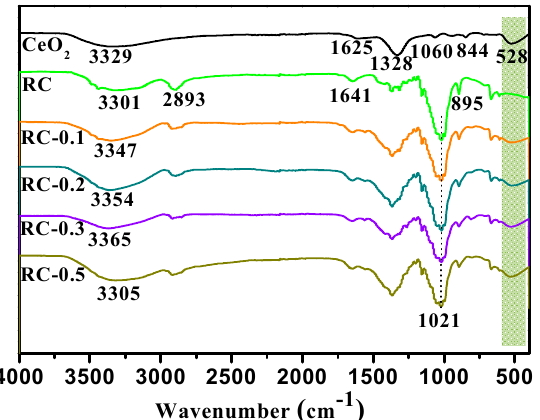
Figure 2. FTIR spectra of CeO 2 particles, RC and RC/CeO 2 nanocomposite films.